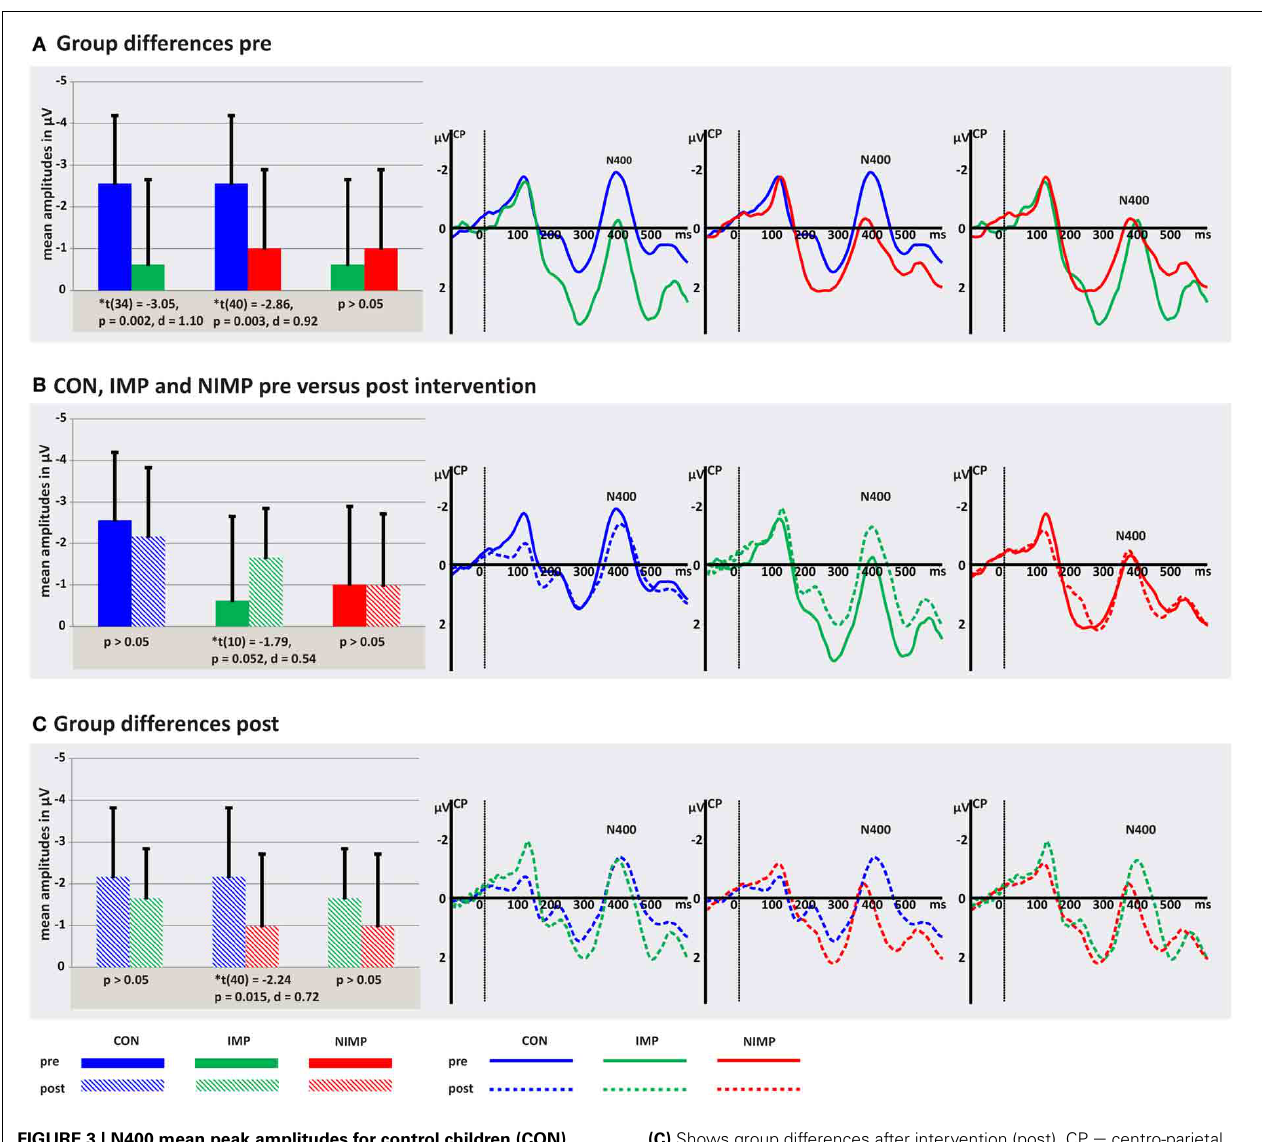
FIGURE 3 | N400 mean peak amplitudes for control children (CON), improvers (IMP), and non-improvers (NIMP). (A) Illustrates group differences before intervention (pre). (B) Depicts treatment effects.